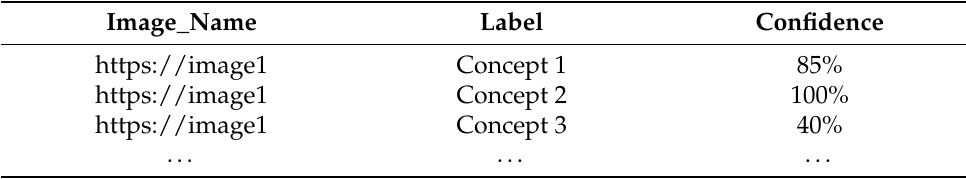
Table 1. Expected annotation of cultural heritage images with